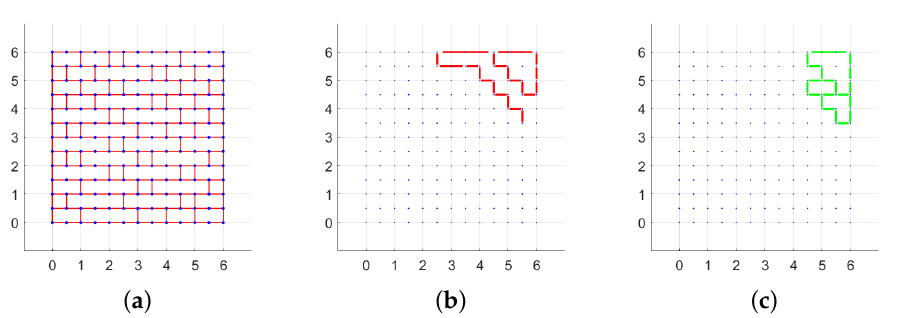
Figure 9. Quasi-periodic masonry with H / W = 1: ( a ) texture, ( b ) layout of displacements ( s ) for right oriented force, ( c ) layout of rotations ( w ) for right oriented force. (Dimensions expressed in units.)